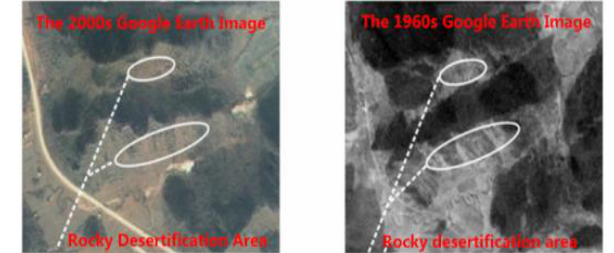
Figure 13. Verification of rocky desertification area